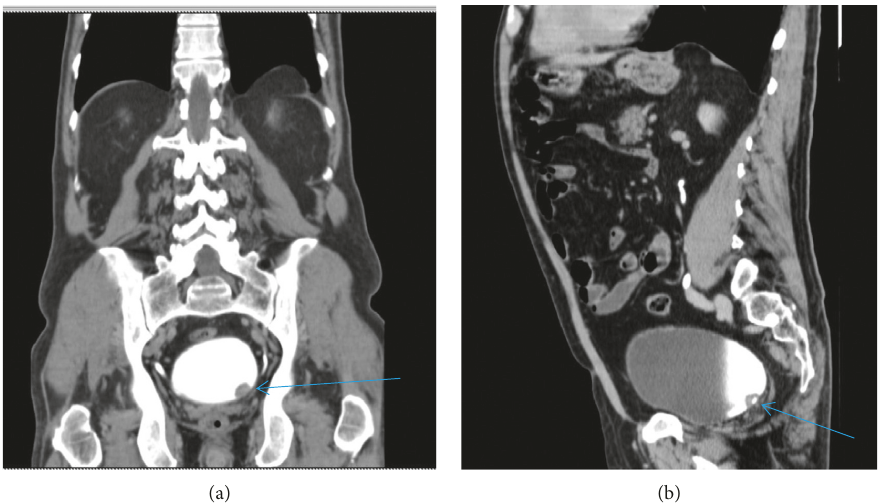
Figure 2: Coronal sections Uro-CT scan with contrast showing filling defect (arrows).